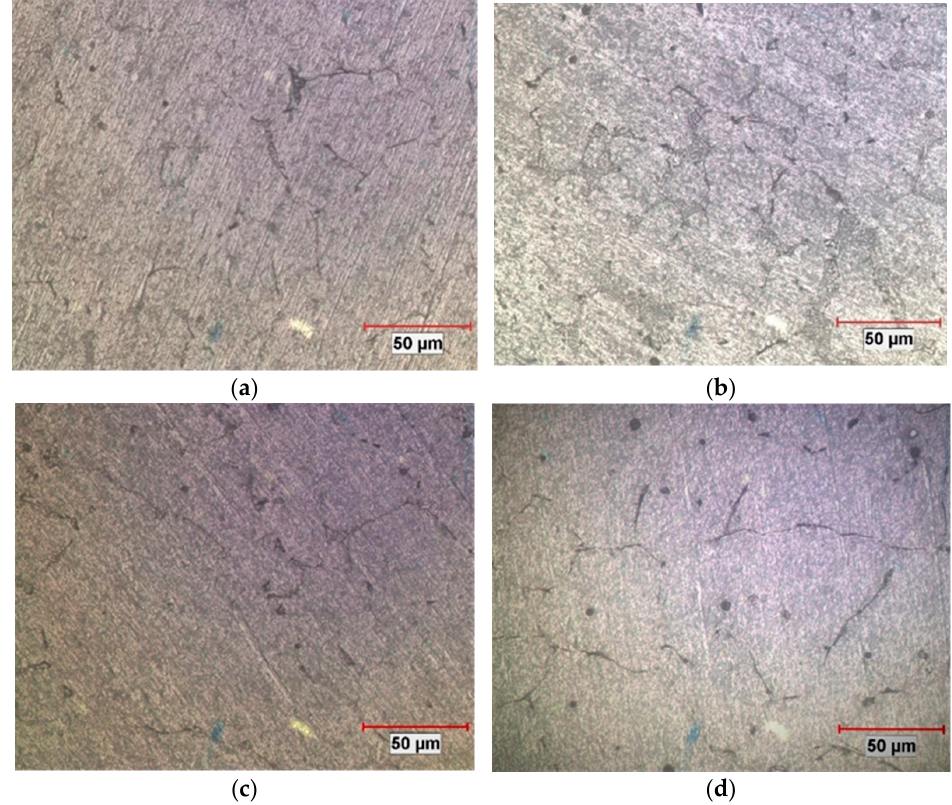
Figure 1. Optical images of ( a ) Al6061; ( b ) Al6061 + 1 wt. % Graphene + 5 wt. % Al 2 O 3 composites; ( c ) Al6061 + 1 wt. % Graphene + 10 wt. % Al 2 O 3 composites; ( d ) Al6061 + 1 wt. % Graphene +15 wt. % Al 2 O 3 composites.